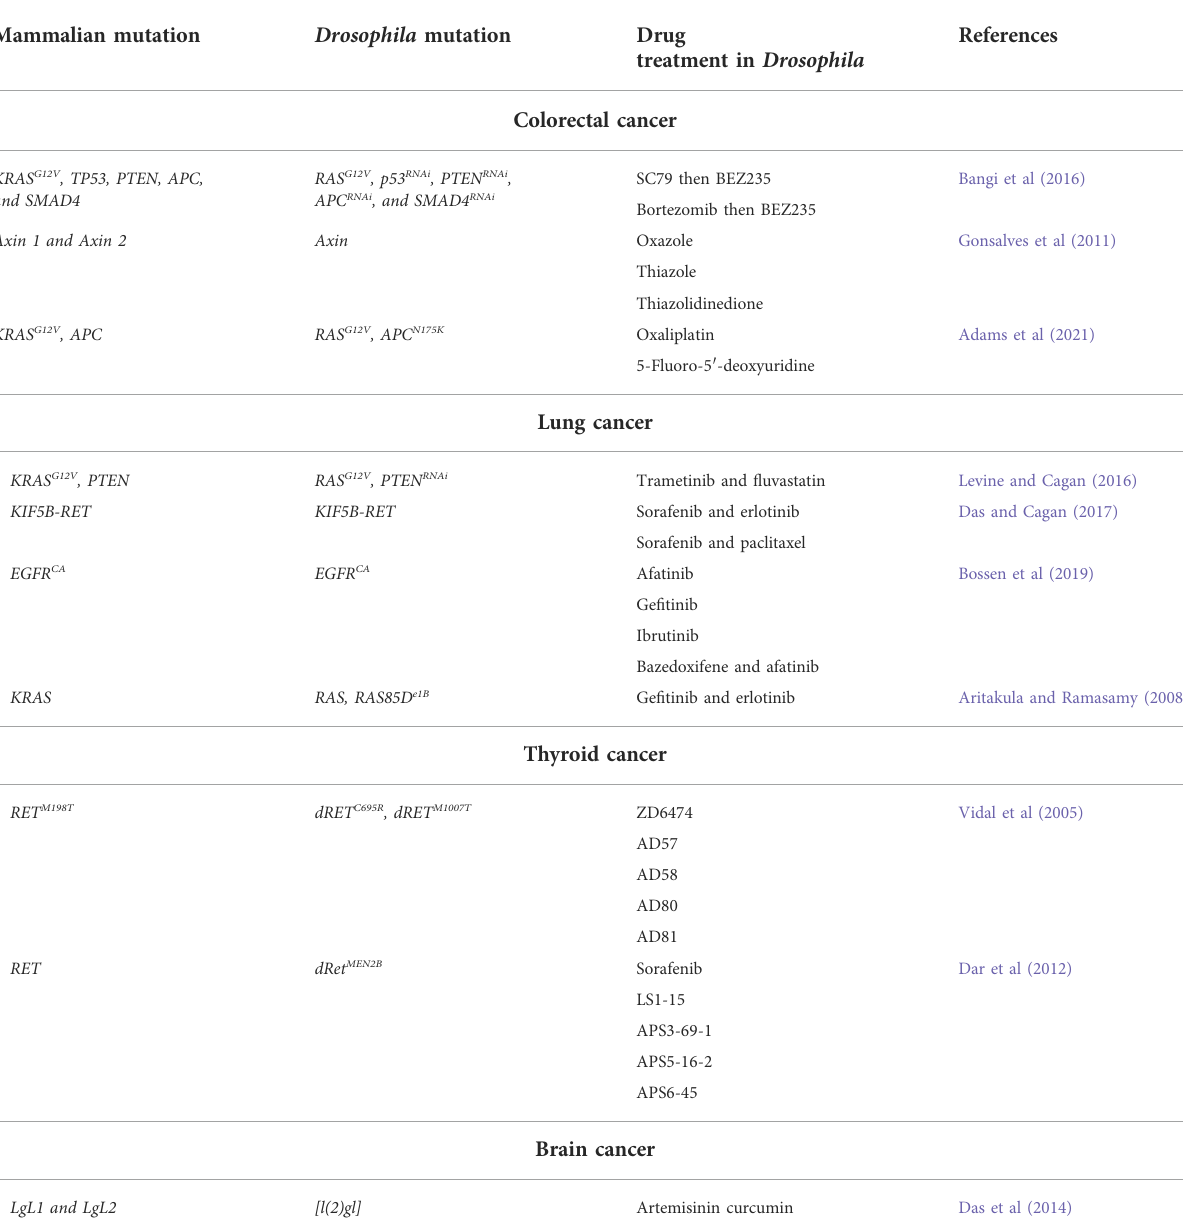
TABLE 1 Drosophila cancer models and drug treatment. Drosophila cancer models are described based on cancer type, mammalian mutation, corresponding Drosophila mutation and drug treatment of the Drosophila